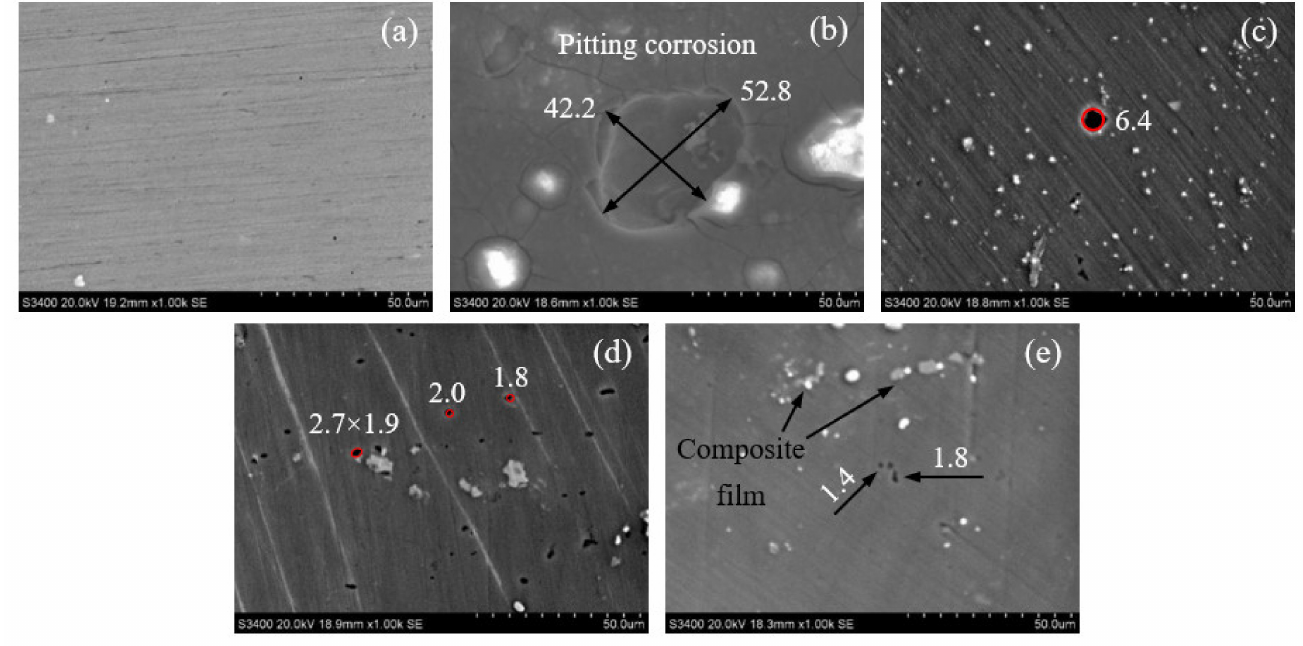
Figure 7. SEM images of 7075 aluminum alloy surface: ( a ) unimmersed surface, ( b ) without inhibitors, ( c ) 200 mg/L Sm(OAc) 3 , ( d ) 200 mg/L Yb(OAc) 3 , and ( e ) 200 mg/L hybrid inhibitors (Sm 3+ :Yb 3+ =